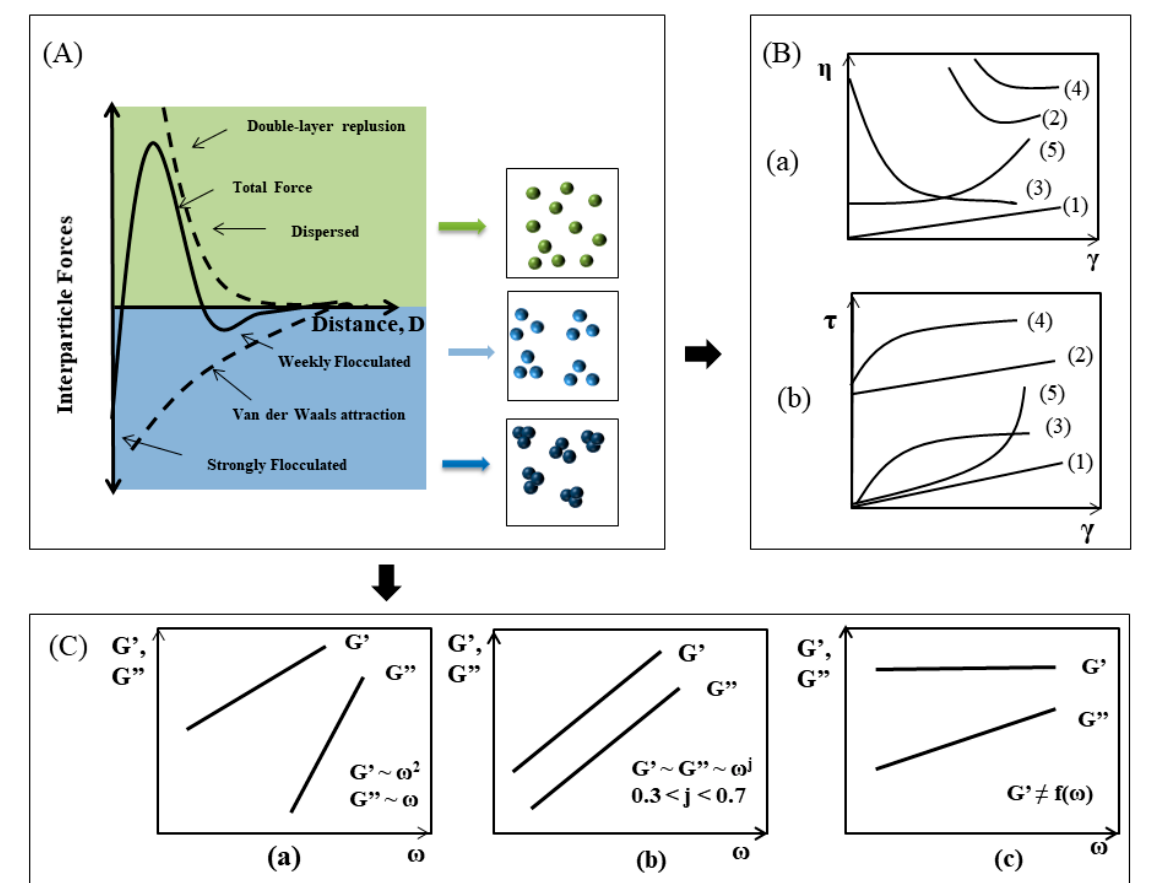
Figure 1. ( A ) Schematic illustration of the interparticle force as a function of the distance between particles. The force is a function of the distance (D) between two particles. As the distance is very low, the interparticle force is strongly attractive (at bottom, right down of ( A )), the particles are strongly flocculated; as the distance is moderate, the interparticle force is strongly repulsive (at middle, right down of ( A )), the particles are dispersed; as the distance is large, the in- terparticle force is attractive again (at top, right down of ( A )), the particles are weakly flocculated. ( B ) Rheological be- haviors of suspensions as steady-shear flow [33] (a) shear rate vs. viscosity; (b) shear rate vs. stress. Curve (1), Newtoni- an flow; Curve (2), Bingham plastic; Curve (3), shear-thinning; Curve (4), pseudoplastic with yield stress; and Curve (5), shear-thickening. ( C ) Schematic illustration of oscillatory behavior as a function of frequency [30]. (a) Liquid-like; (b) gel-like; and (c) solid-like. The rheological properties of suspension shown in ( B , C ) are determined by the interparticle forces shown in ( A ).Reprinted with permission[30]. Copyright (2000), WILEY-VCH.